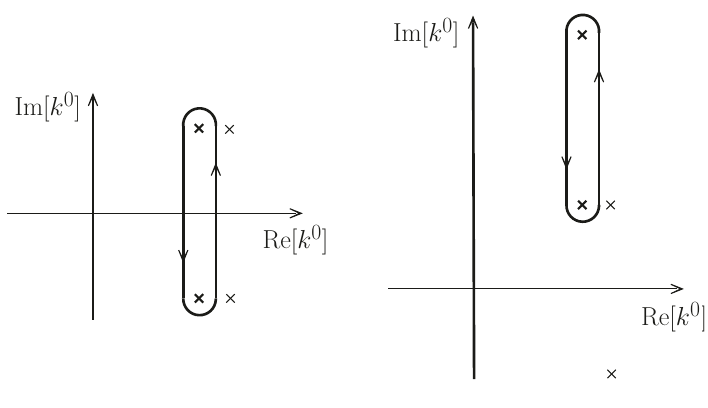
Figure 7 . Lee-Wick